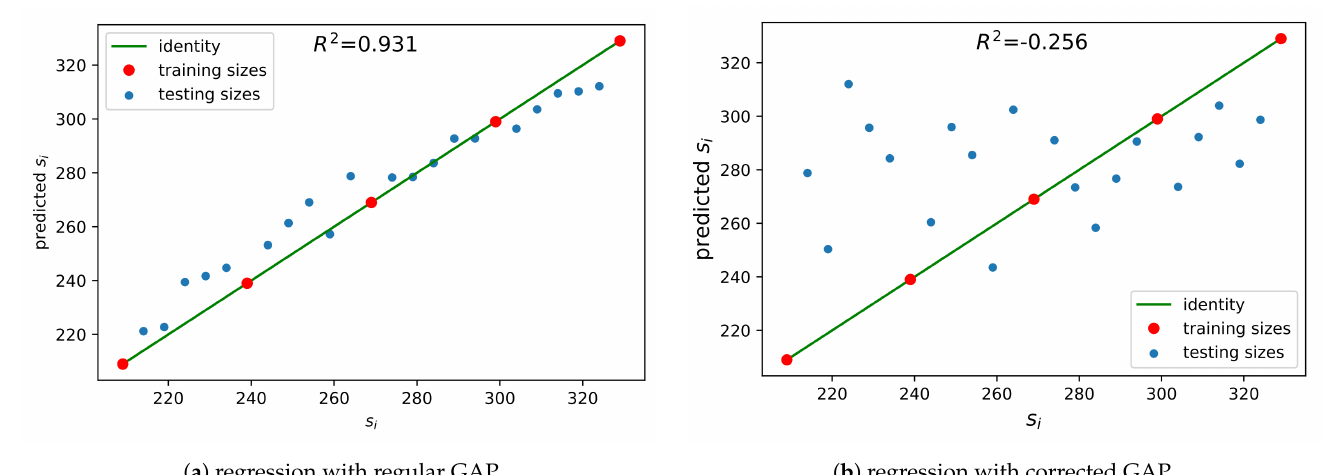
Figure 7. Regression of size s i with noise inputs: ( a ) Regression at layer mixed0 for regular GAP; ( b ) Regression at layer mixed0 for corrected GAP. The regression is evaluated as the R 2 of the prediction of scale measures on held-out noise images.